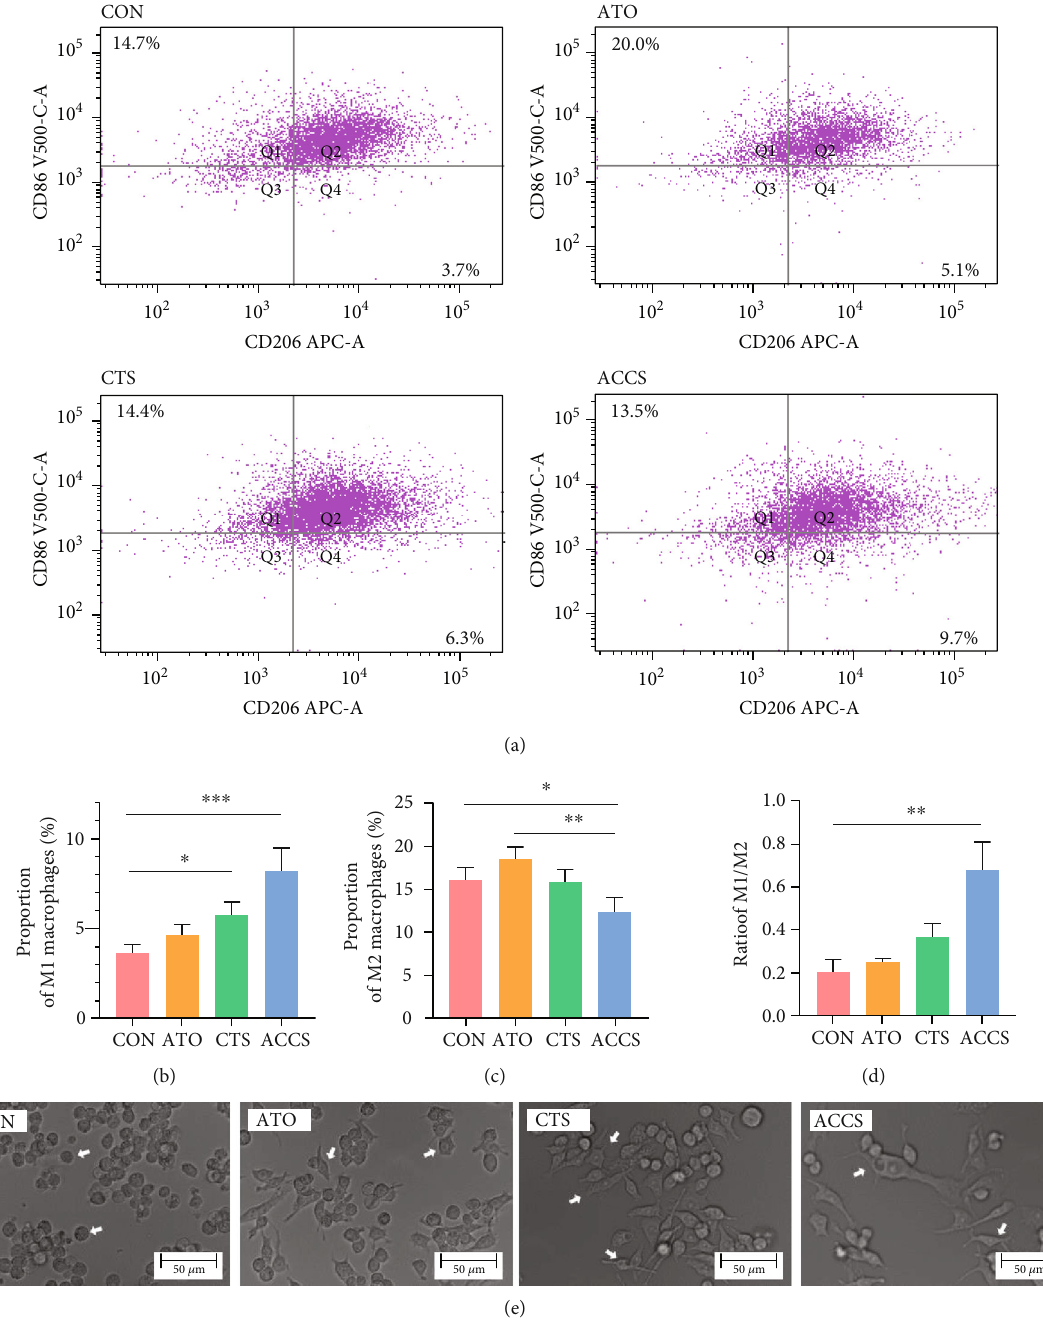
Figure 3: The e ff ect of ACCS on the polarization of macrophages. (a) Macrophages in tumor tissues. (b) The proportion of M1. (c) The proportion of M2. (d) The ratio of M1/M2. (e) Primary macrophages under di ff erent drug